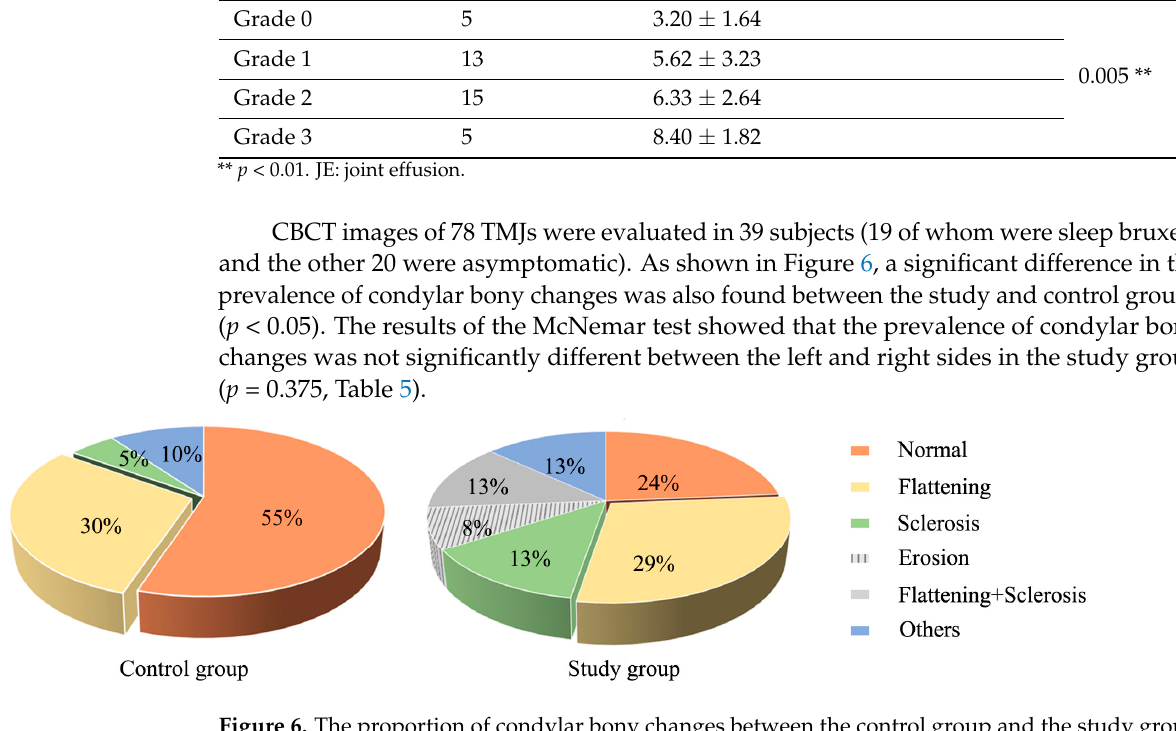
Figure 6. The proportion of condylar bony changes between the control group and the study group. The statistical results: x 2 = 14.313, p = 0.007. Table 5. A comparison of qualitative data on left and right TMJs in sleep bruxers.